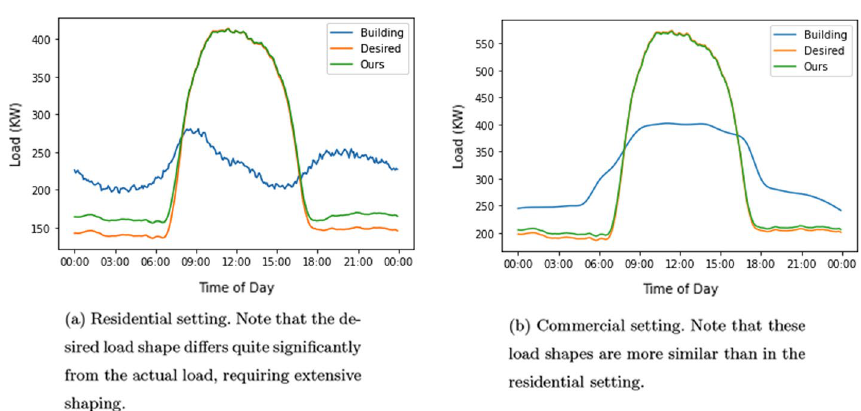
Fig. 4 Comparison of average actual load and desired load shapes (matching renewable